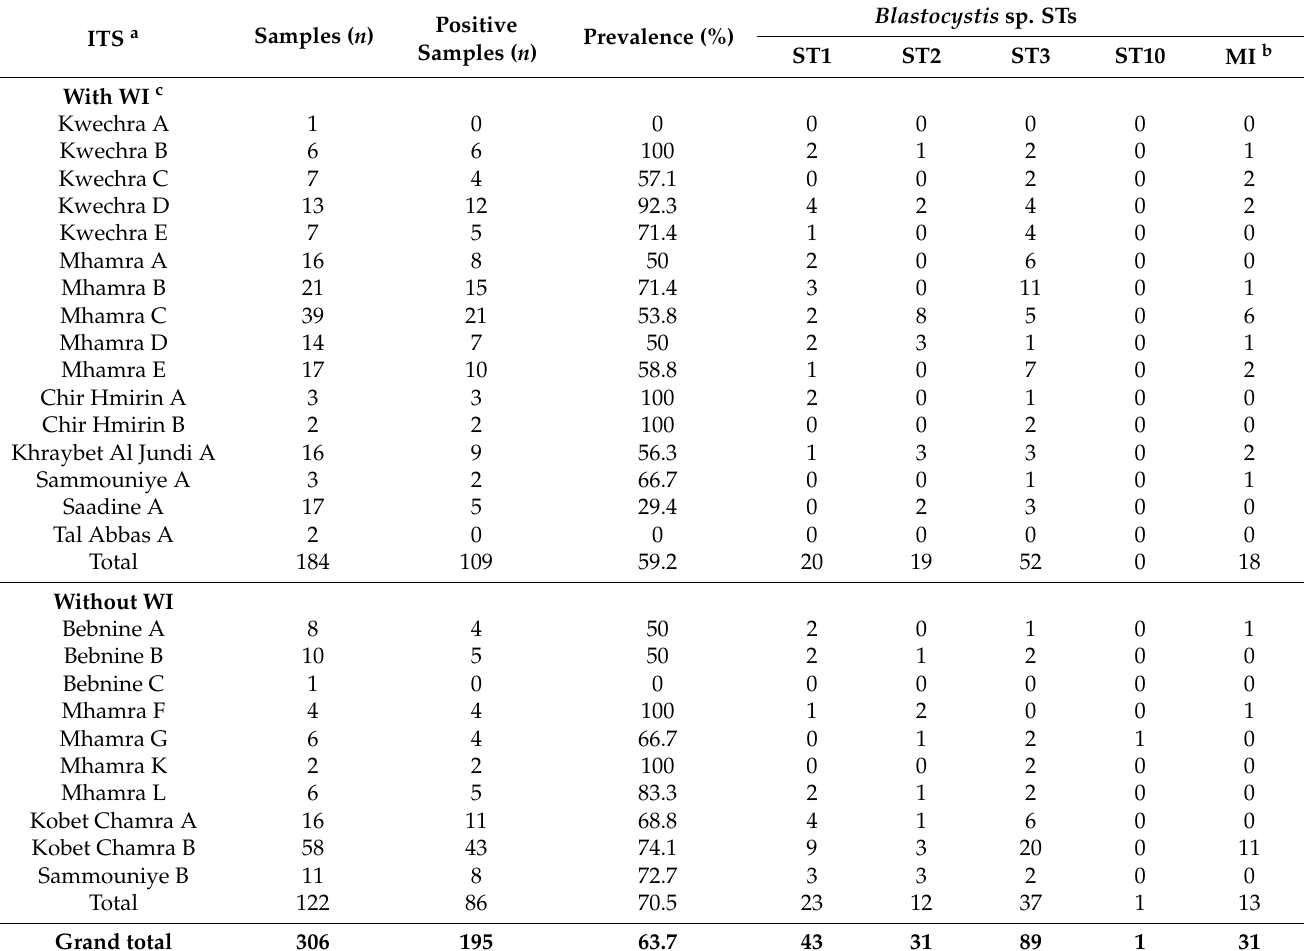
Table 1. Prevalence and ST distribution of Blastocystis sp. in the ITS housed by Syrian refugees screened in the present study. ITS a Samples ( n )